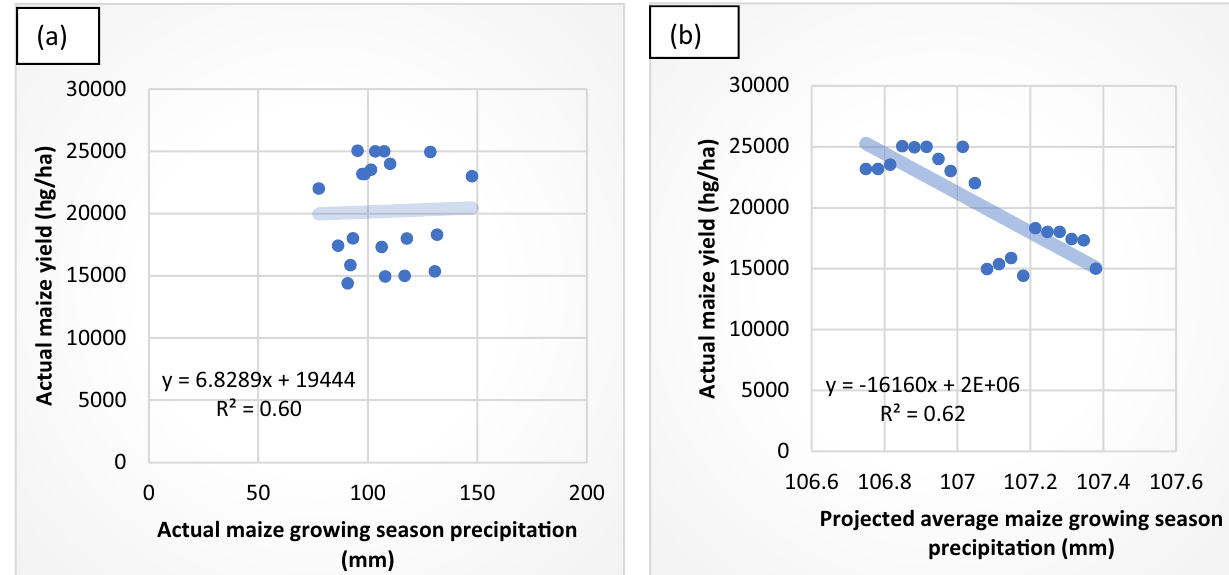
Fig. 7 Scatter plots of a actual growing season precipitation against actual maize yield and b projected growing season precipitation and actual maize